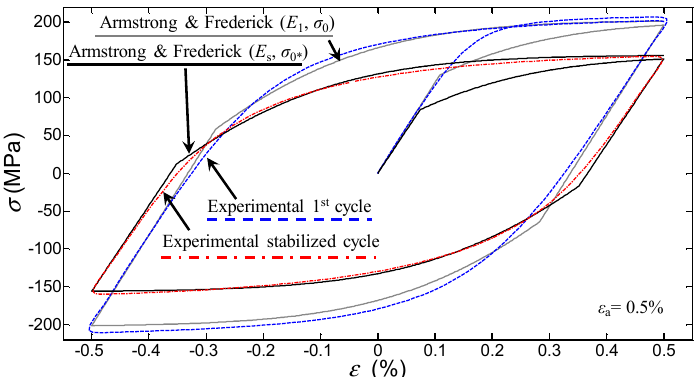
Figure 2. Comparison between simulated and experimental (first and stabilized) cycle.